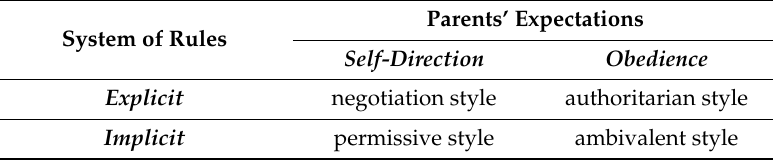
Table 1. Parenting